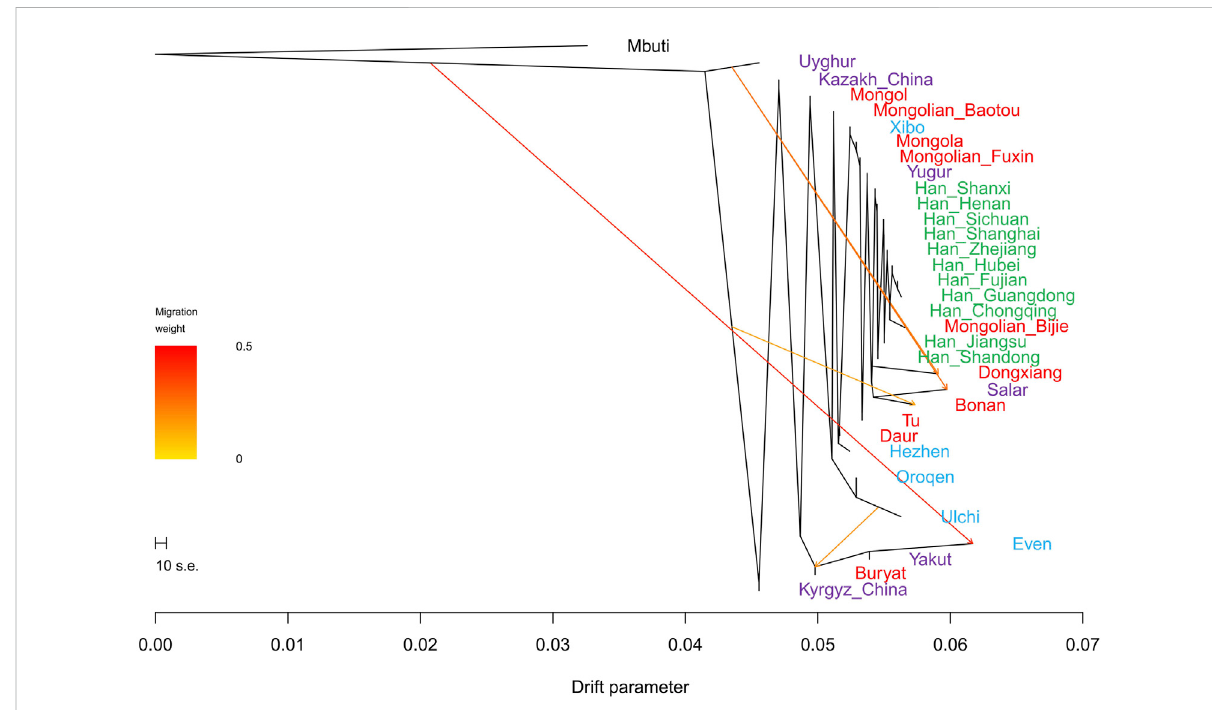
FIGURE 10 TreeMix-based maximum-likelihood phylogenetic tree with four migration events showed the population relationship among Han people and Turkic, Tungusic, and Mongolic speakers. Different colors represent different language